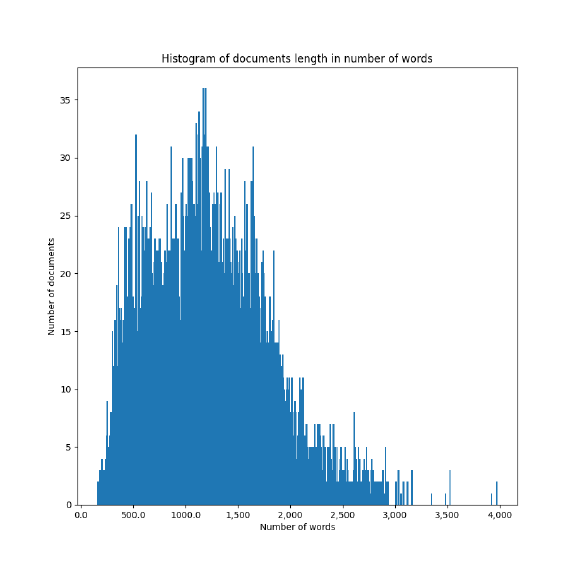
Figure 16. Class frequency distribution for Ohsumed.